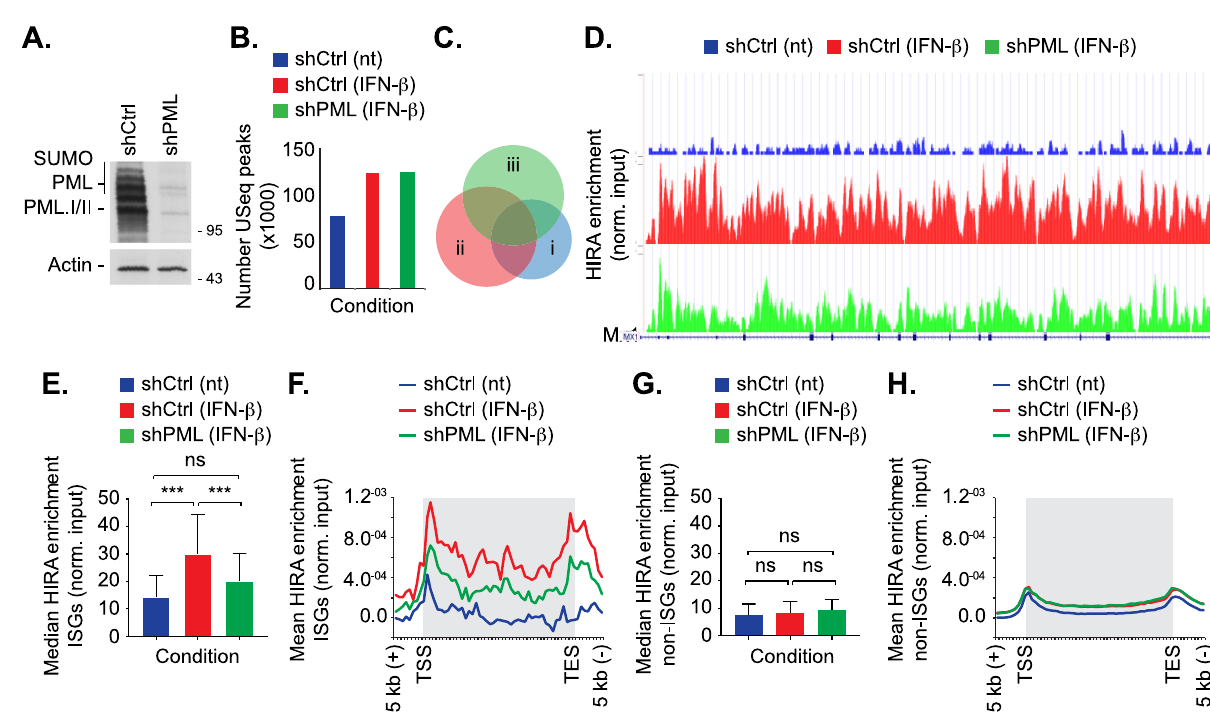
Fig 6. PML enhances HIRA binding to ISGs following IFN- β stimulation. Primary fibroblast (IMR-90) cells were stably transduced to express non- targeting control (shCtrl) or PML-targeting (shPML) shRNAs. Cells were either mock treated (no treatment, nt) or stimulated with IFN- β (2000 IU/ml) for 24 h prior to native ChIP-seq using a panel of HIRA mAbs [69, 74]. (A) Western blot analysis of the expression levels of PML in whole cell lysates derived from untreated shCtrl or shPML cells. Actin is shown as a loading control. Molecular mass markers are indicated. (B) Bar chart showing the number of unique sequencing (USeq) peaks identified following HIRA ChIP-seq for each treatment condition (as indicated; S7 Table). (C) Venn diagram showing the intersection in bp for each condition (i, shCtrl (nt); ii, shCtrl + IFN- β ; iii, shPML + IFN- β ). (D) Representative UCSC plot of the ISG Mx1 showing relative HIRA binding under each condition (as indicated). The Y-axis represents library normalised read count. For the gene track, introns are shown as horizontal lines and exons as vertical boxes. (E) Bar graph showing median gene body HIRA enrichment at 49 core ISGs under each condition (as indicated; S7 Table). 95% confidence interval shown. ��� P < 0.001; one-way Anova (tukey), ns; not significant. (F). Composite profile of HIRA enrichment over 49 core ISGs. Shaded grey boxes represent gene body sequences located between transcriptional start and end sites (TSS and TES, respectively). Y-axis indicates mean HIRA enrichment (normalised to input control) per bin width. (G) Bar graph showing the median HIRA enrichment in the gene body of 49 coding non-ISGs equal in size to core ISGs (as in E). 95% confidence interval shown. ns (not significant); one- way Anova (tukey). (H) Composite profile of HIRA enrichment at the same 49 coding non-ISGs as described in G.